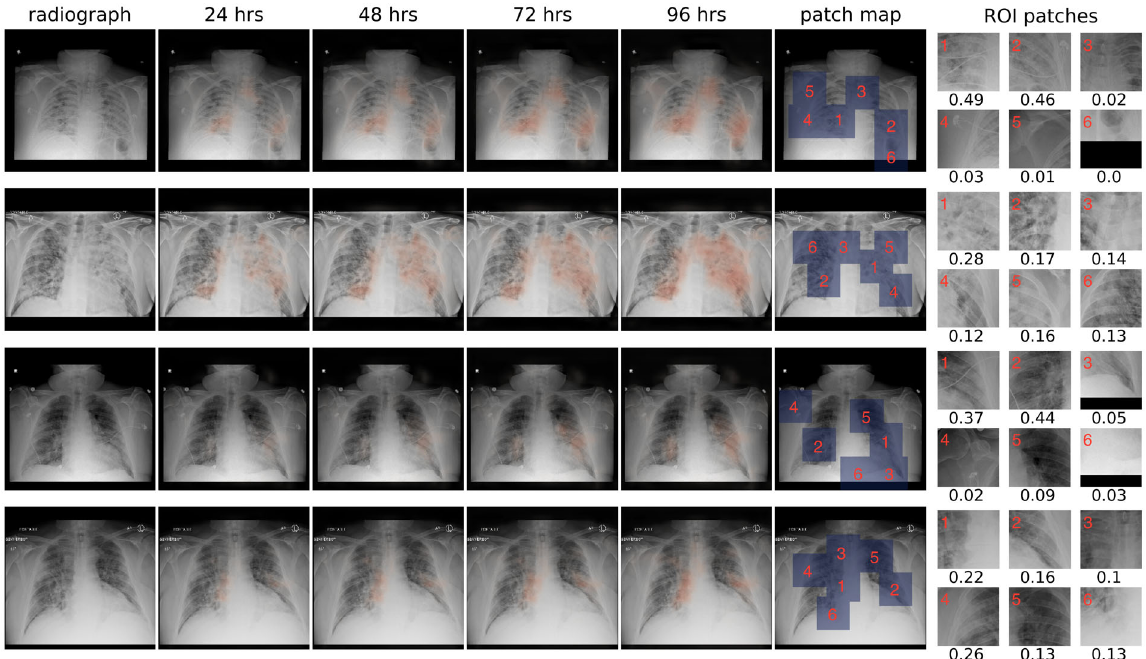
Fig. 3 Explainability of COVID-GMIC. From left to right: the original X-ray image, saliency maps for clinical deterioration within 24, 48, 72, and 96 h, locations of region-of-interest (ROI) patches, and ROI patches with their associated attention scores. All four patients were admitted to the intensive care unit and were intubated within 48 h. In the fi rst example, there are diffuse airspace opacities, though the saliency maps primarily highlight the medial right basal and peripheral left basal opacities. Similarly, the two ROI patches (1 and 2) on the basal region demonstrate comparable attention values, 0.49 and 0.46, respectively. In the second example, the extensive left mid to upper-lung abnormality (ROI patch 1) is highlighted, which correlates with the most extensive area of parenchymal consolidation. In the third example, the saliency maps highlight the left mid lung (ROI patch 1) and right hilar/infrahilar regions (ROI patch 2) which show groundglass opacities. In the last example, the saliency maps highlight the right infrahilar region (ROI patch 1) and the left mid lung periphery (ROI patch 2). The ROI patch 4 is also assigned the highest attention score as a predictive region of clinical deterioration, which corresponds to dense peripheral right upper lobe